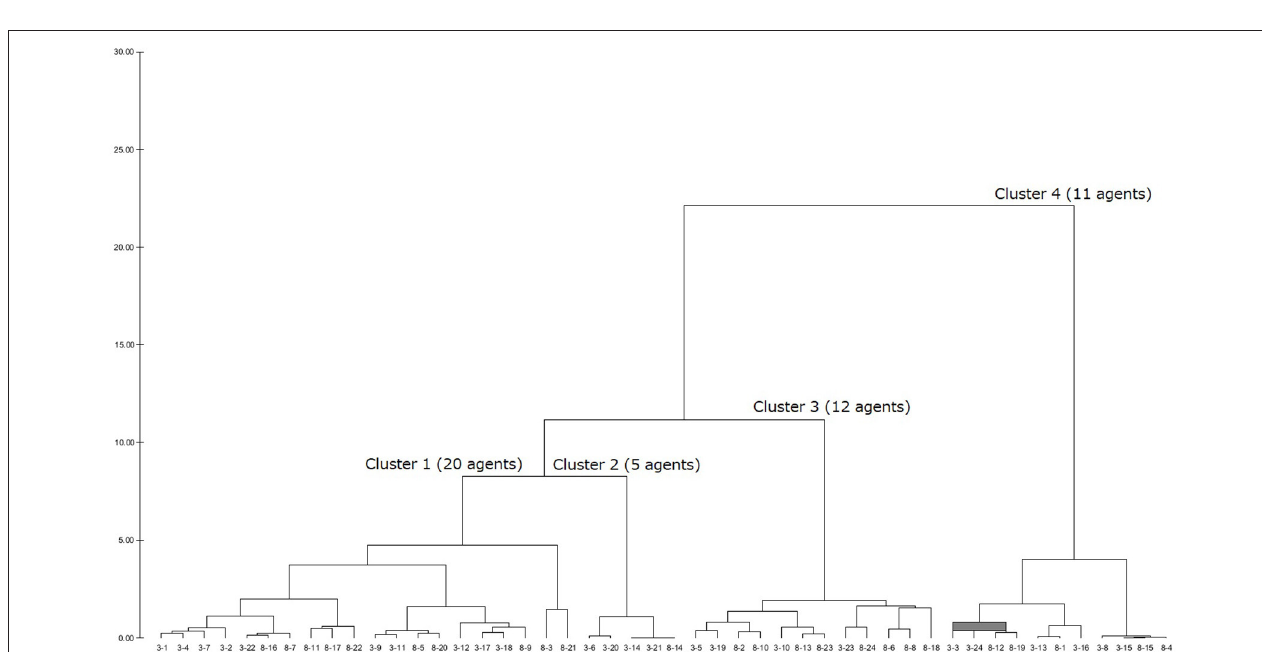
FIGURE 4 | Generated dendrogram (LUIG44).